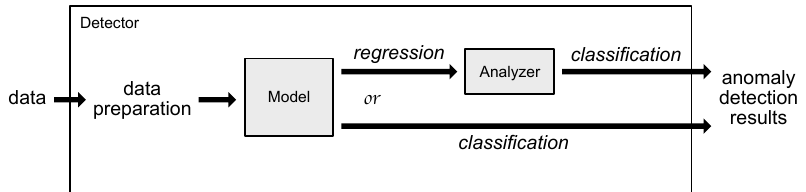
Figure 6. High-level system architecture. c (cid:13) 2018 IEEE. Reprinted, with permission, from Wielgosz, M.; Skocze´n, A.; Wiatr, K. Looking for a Correct Solution of Anomaly Detection in the LHC Machine Protection System. 2018 International Conference on Signals and Electronic Systems (ICSES), 2018, pp. 257–262